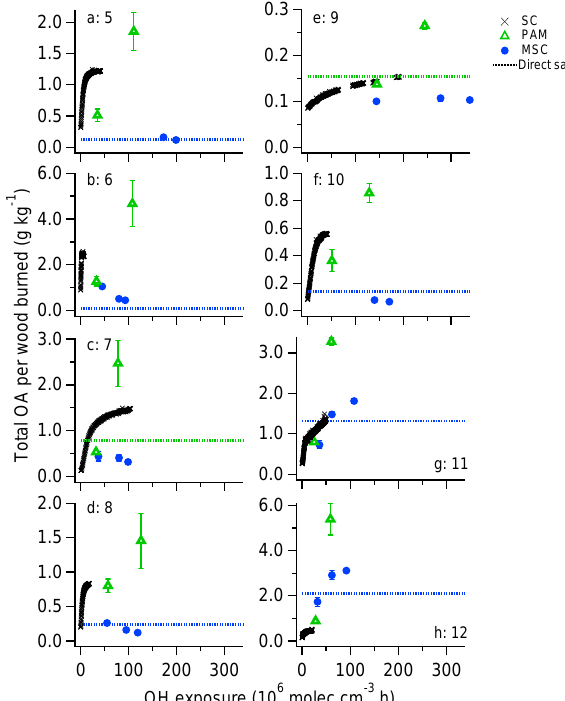
Figure 5. Total organic aerosol after aging normalized to the mass of wood burned as a function of OH exposure for each wood- combustion experiment ( a–h ; experiments 5–12). Individual data points correspond to the SC and the PAM and MSC when sampling from the SC and the dashed lines correspond to direct sampling (un- known OH exposure). For (c) and (e) (experiments 7 and 9), direct sampling corresponds to the PAM and for all other experiments, di- rect sampling corresponds to the